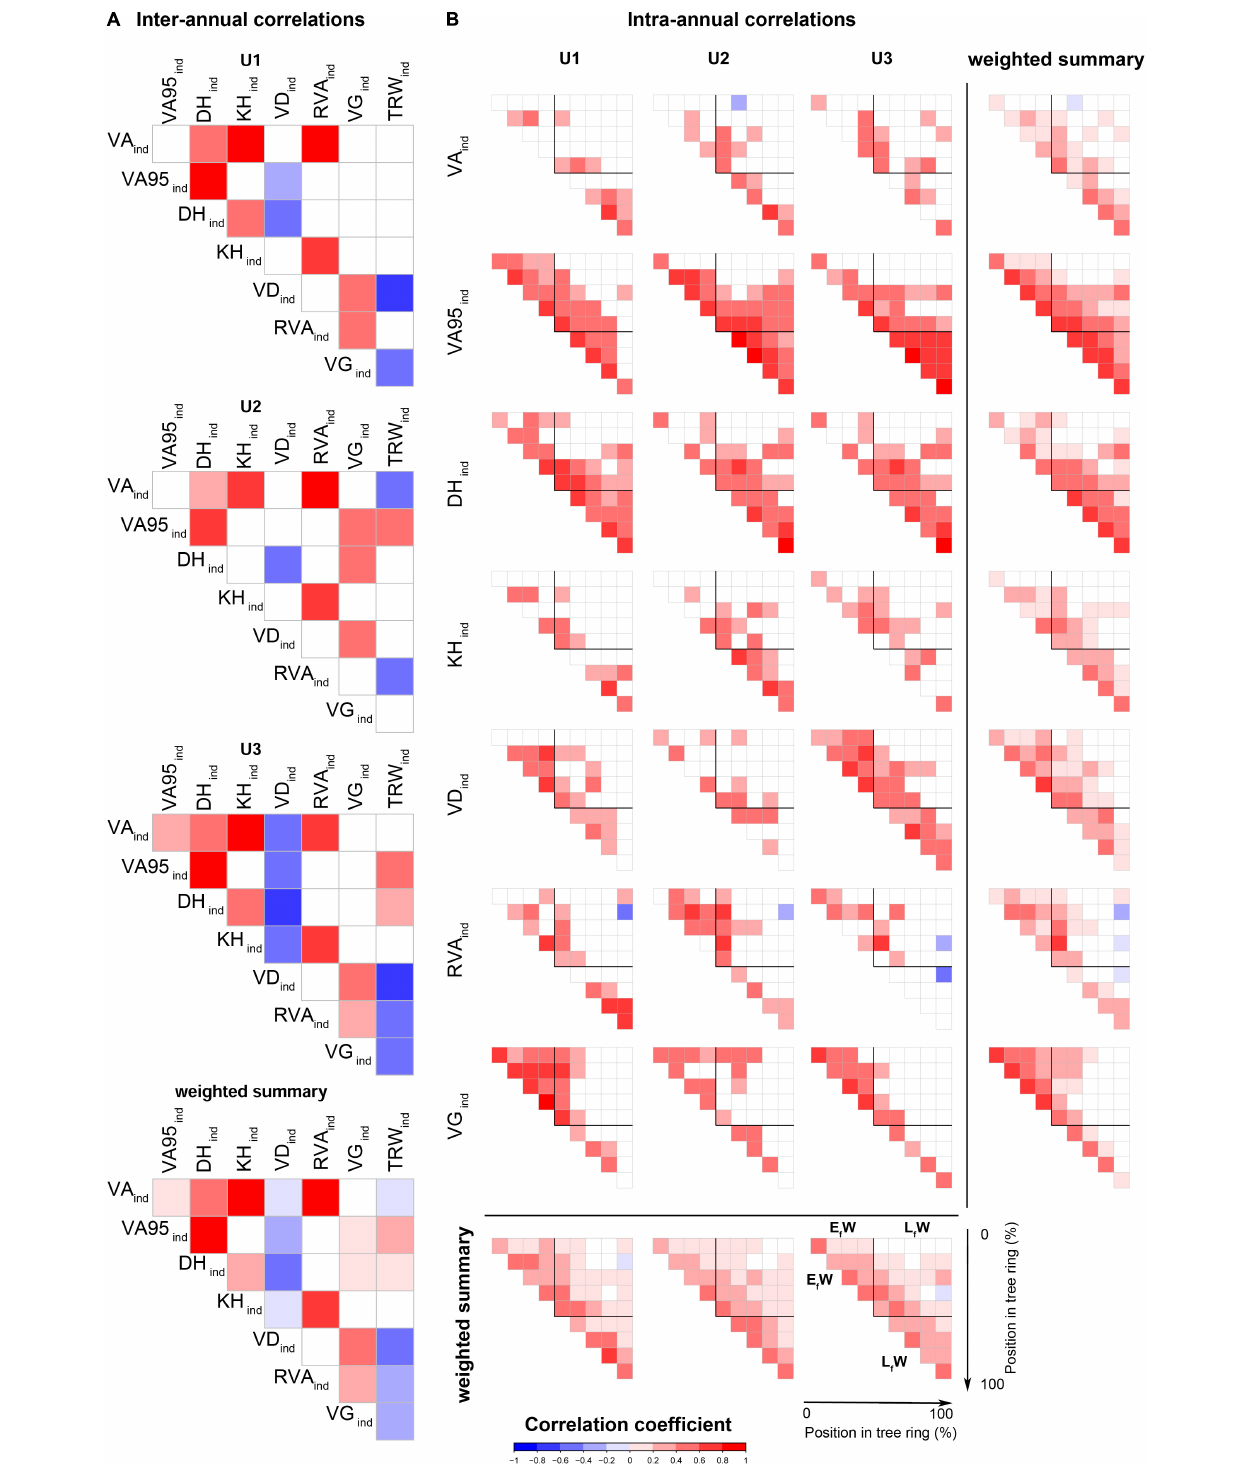
FIGURE 5 | (A) Inter-annual Spearman’s correlations among all indexed series of anatomical traits and (B) intra-annual Spearman’s correlations in each of the sector’s indexed series of anatomical traits at the three study sites: U1—1,200 m a.s.l.; U2—1,600 m a.s.l.; U3—1,950 m a.s.l. Colors represent the correlation coefficient values (r). Only significant correlations ( P -value < 0.05) are presented. Weighted summarized values are calculated as the sum of the significant correlation coefficients of the sites and traits, divided by the total number of sites and traits, respectively. E f W: Early formed wood (0–50% of the ring); L f W: late formed wood (50–100%), assuming each corresponds to half of each ring. For the anatomical trait abbreviations, see Figure 2 .